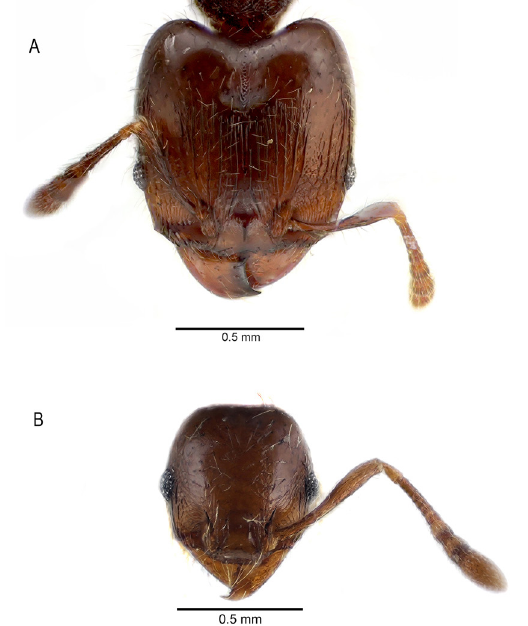
Fig 1. Pheidole protaxi sp. nov., head: full-face view. A: holotype major worker, [LBSA_SA_14013667]. B: paratype minor worker, [LBSA_SA_14012040].